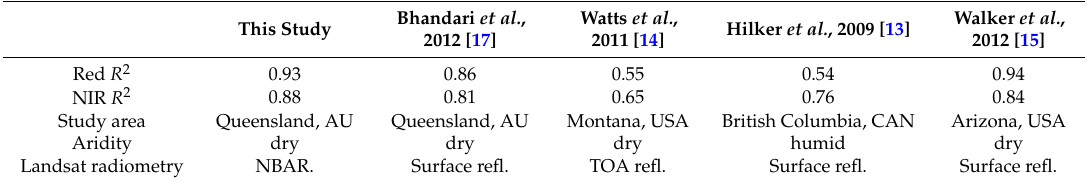
Table 2. Literature-based comparison of STARFM red and NIR band prediction performance as a function of environmental setting and Landsat radiometric processing